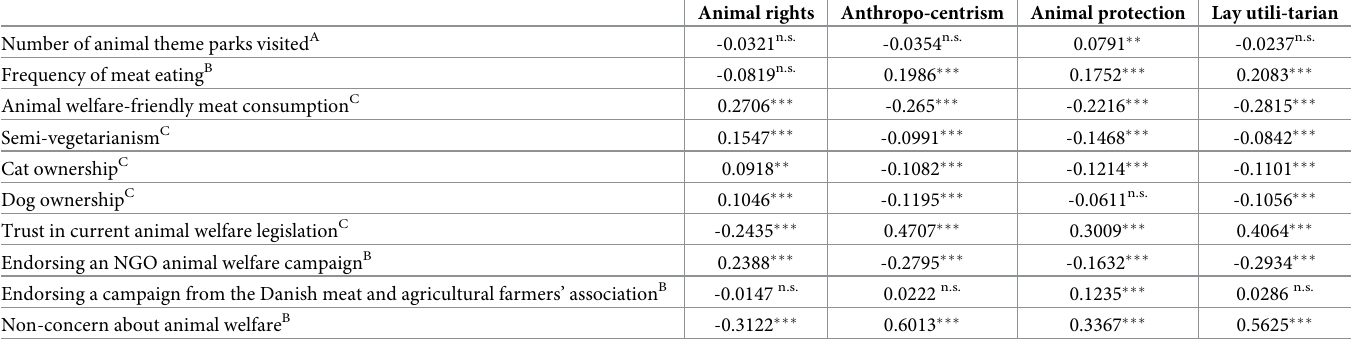
Table 5. Unadjusted correlation coefficients between animal ethics orientations and stated behaviour in areas where animals are used, having a cat or dog, and ani- mal-related opinions and trust (N = 974–1002). Animal rights Anthropo-centrism Animal protection Lay